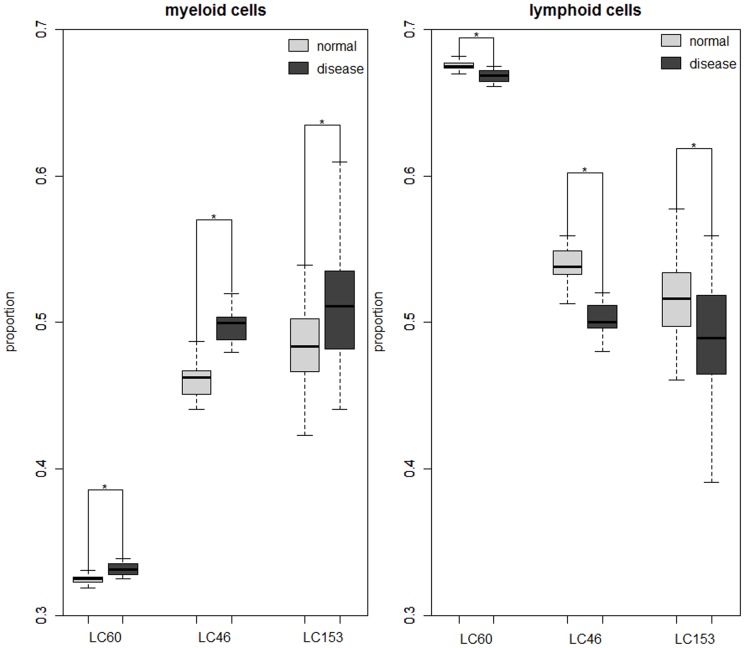
Boxplot of proportions of myeloid and lymphoid cells in lung cancer and control PWB samples.The estimated proportions of myeloid and lymphoid cells in lung cancer and healthy PWB samples for each dataset. * denotes statistically significant differences (P<0.05). Abbreviations are same as in Table 1.